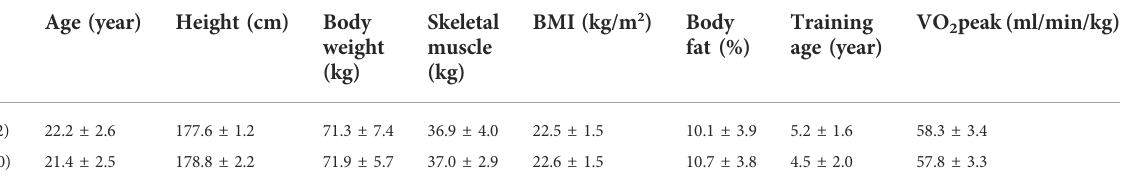
TABLE 1 Physical characteristics of runners included in the analysis